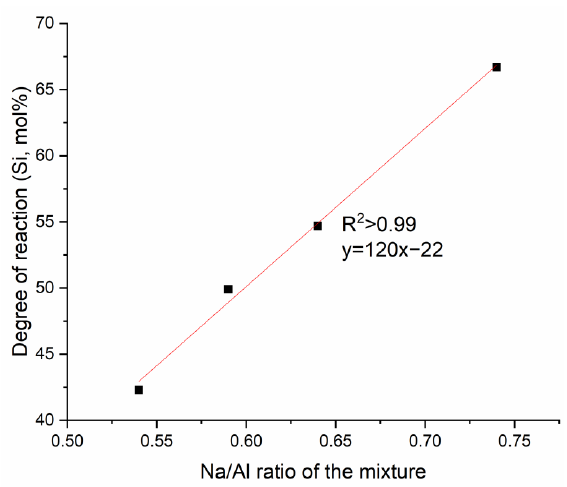
Figure 3. Degree of reaction from NMR analysis at different Na/Al ratios for the non-Ca mixtures. Table 2. Amount and composition of geopolymer gel and unreacted metakaolin in the non-Ca mixtures as determined using